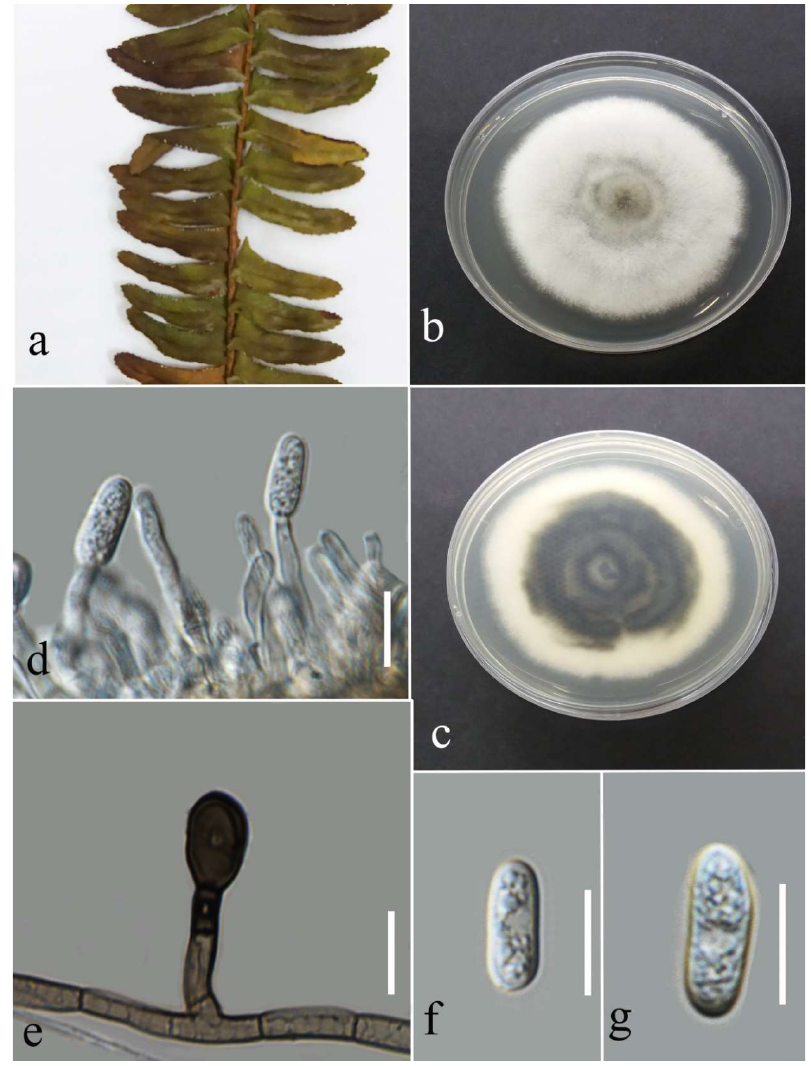
Figure 22. Morphology of Colletotrichum fructicola (MFLUCC 22-0147) obtained from Nephrolepis cordifolia : ( a ) blight on the leaf margin in the host; ( b , c ) upper and reverse views of the colony after seven days of growth on PDA; ( d ) conidiogenous cell; ( e ) appressorium; ( f , g ) conidia. Scale bars = 10 µ